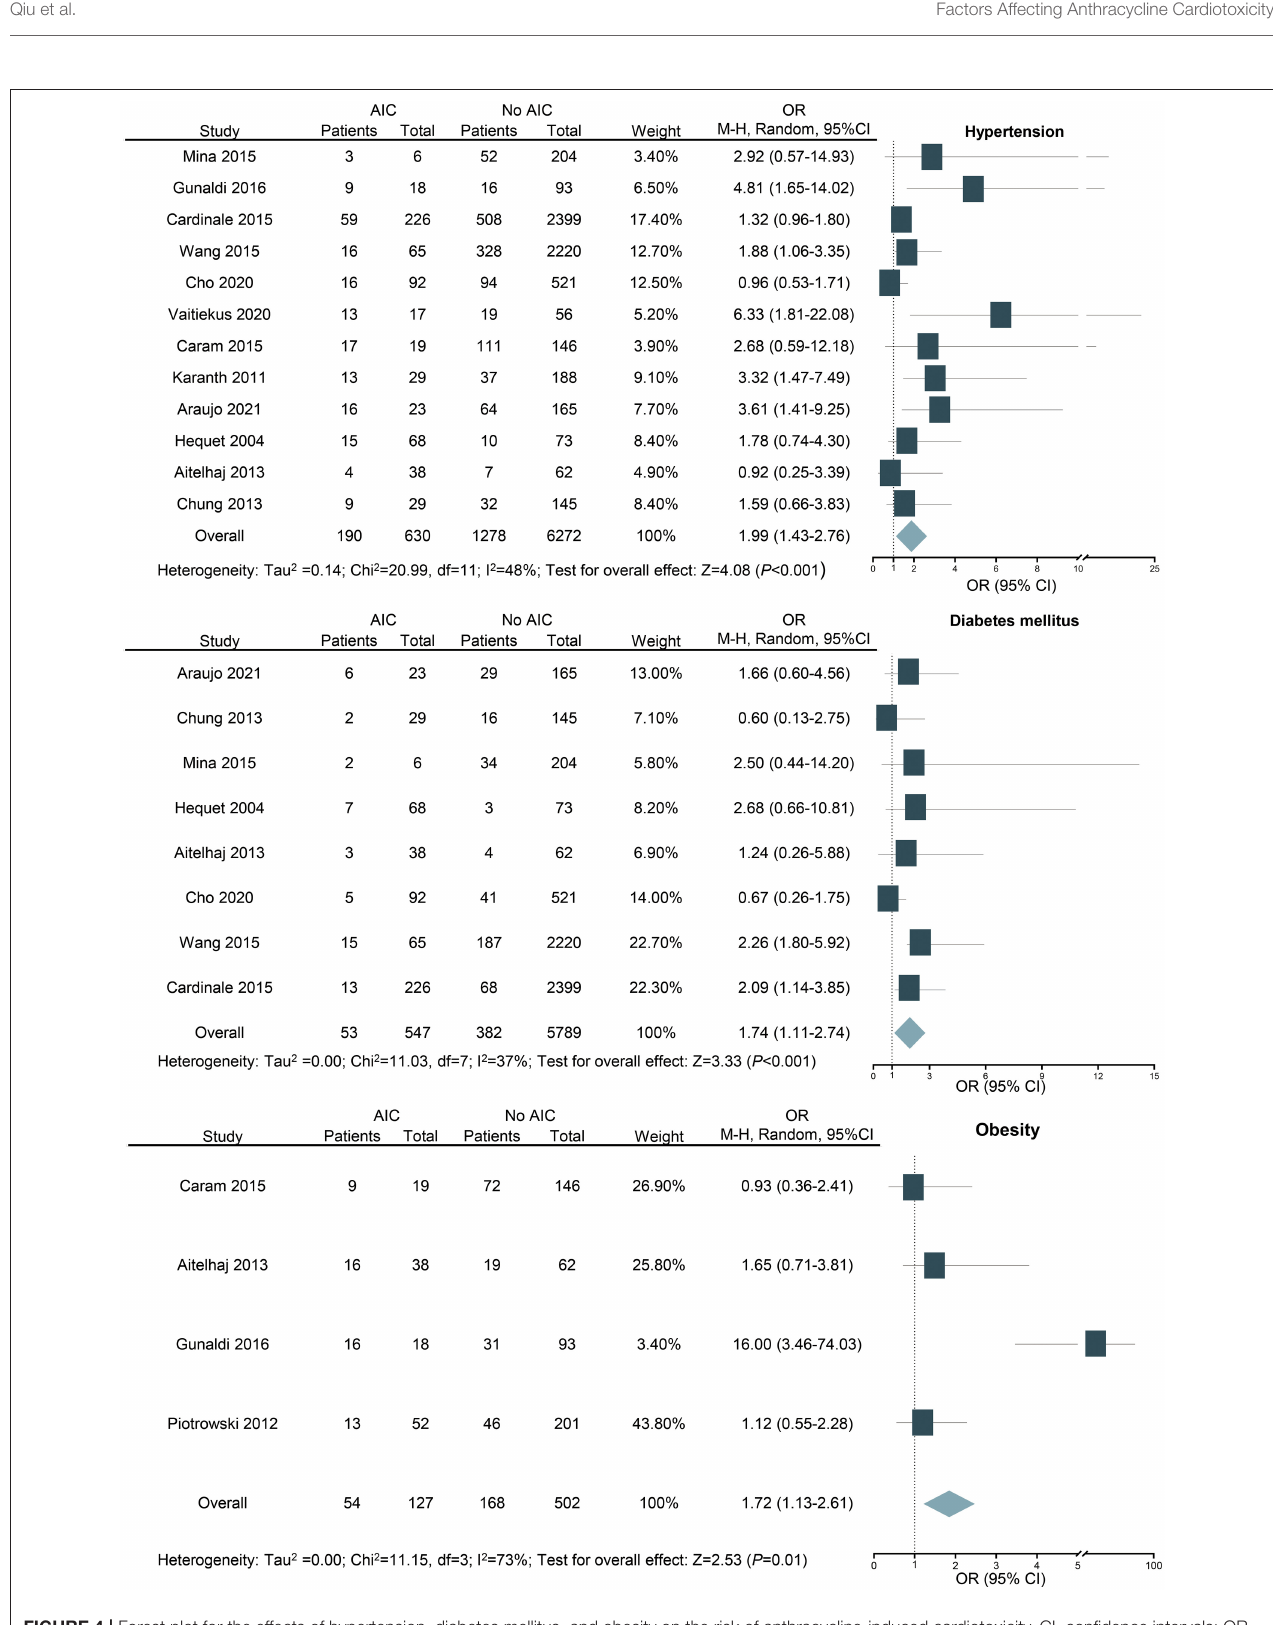
Frontiers in Cardiovascular Medicine |